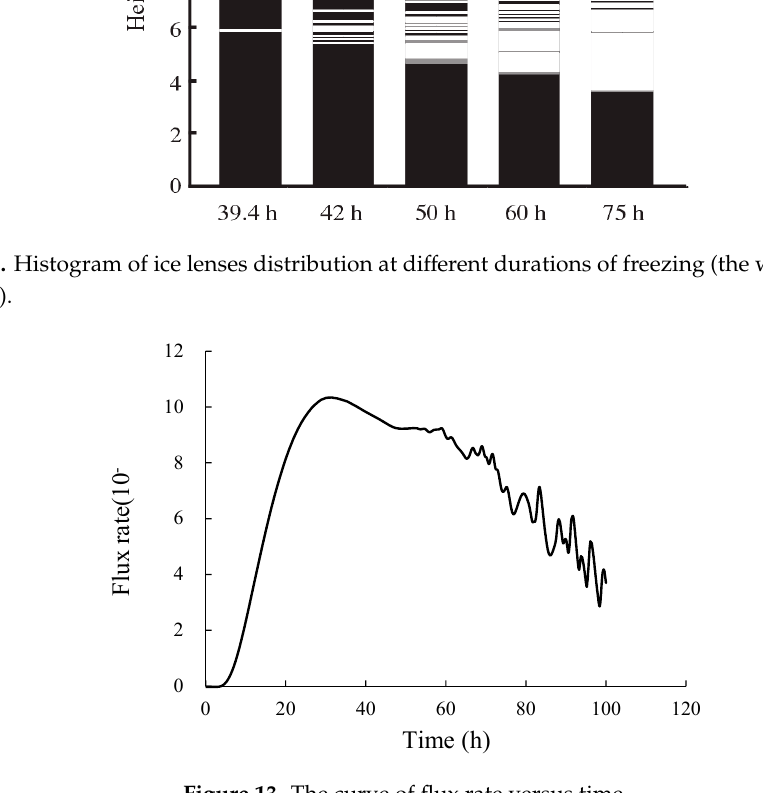
Figure 13. The curve of flux rate versus time.